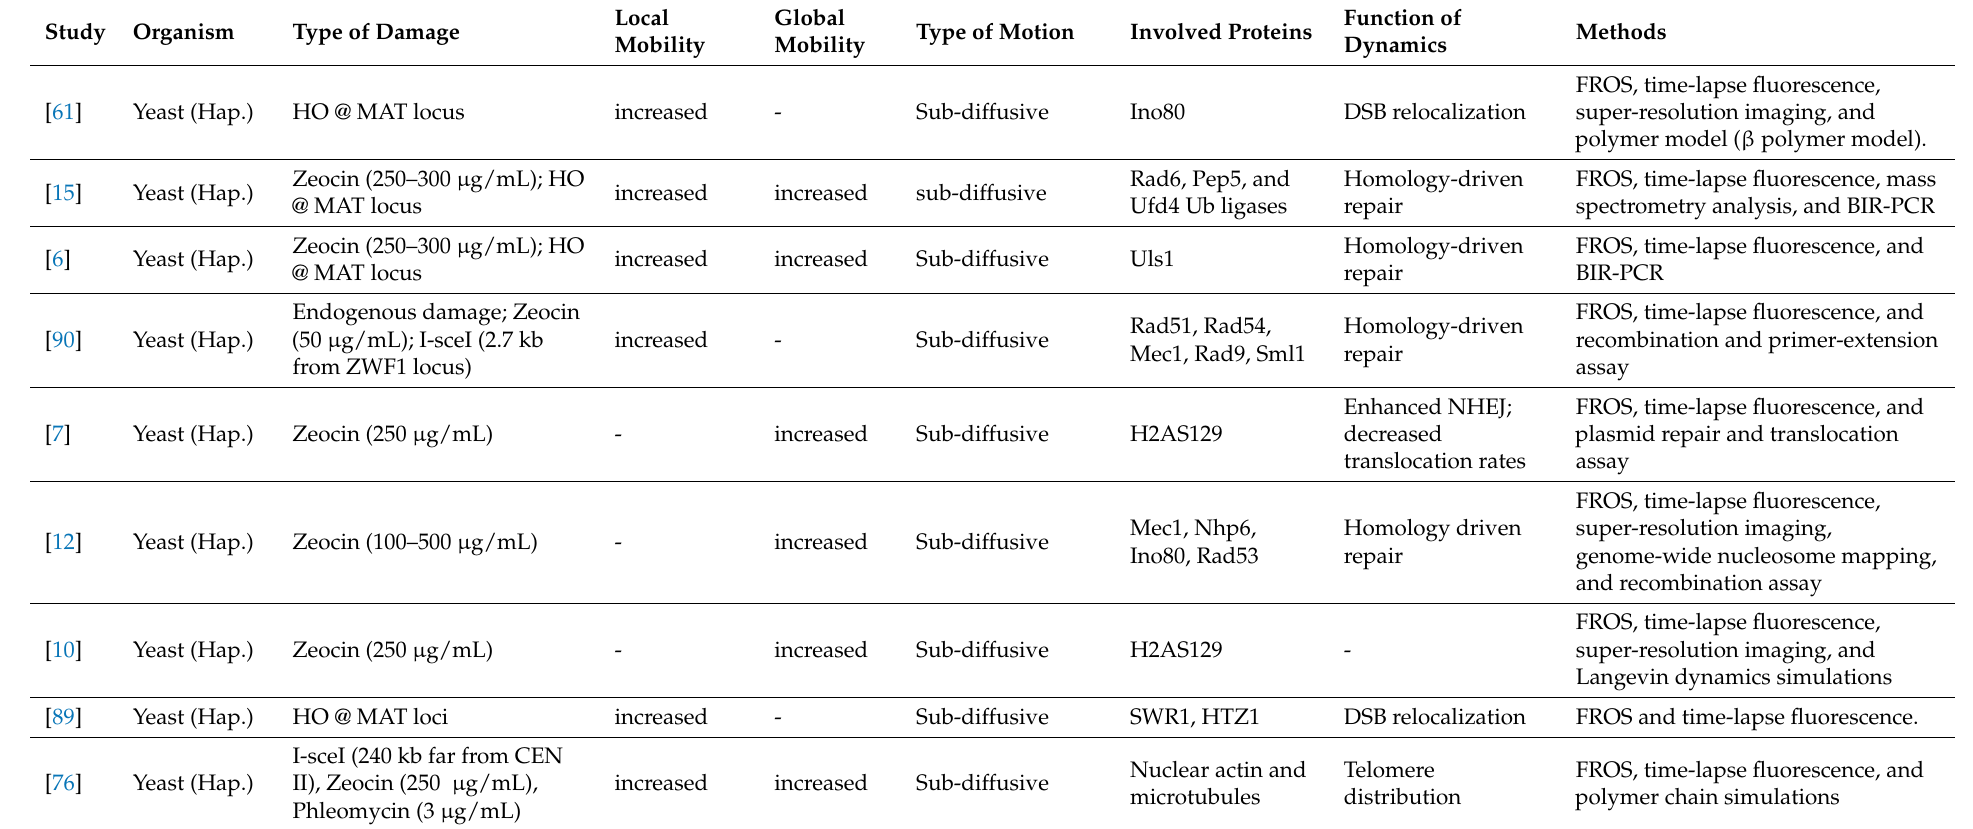
Table 1. Summary table of yeast studies exploring chromatin dynamics upon DSB induction in budding